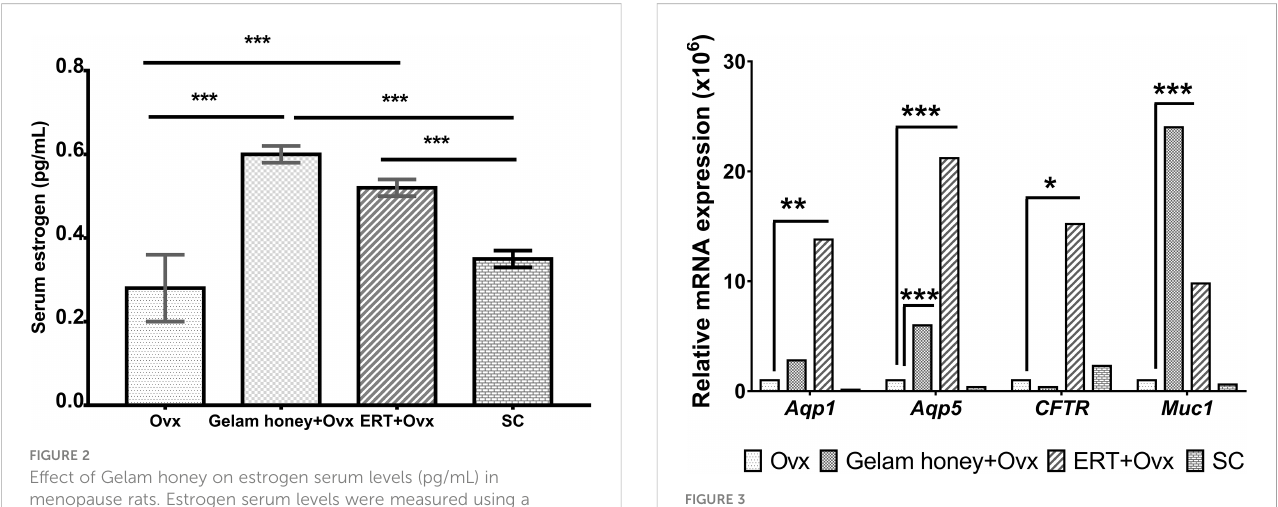
FIGURE 3 mRNA mean expression for genes Aqp1, Aqp5, CFTR and Muc1 in vagina tissues. The level of signi fi cance was set at p < 0.05 (*), p < 0.01 (**), and p < 0.001 (***) Gelam honey+Ovx: Gelam honey and bilateral oophorectomized group. ERT+Ovx: Estrogen replacement therapy and bilateral oophorectomized group. Ovx: Bilateral oophorectomized group. SC: Sham group.